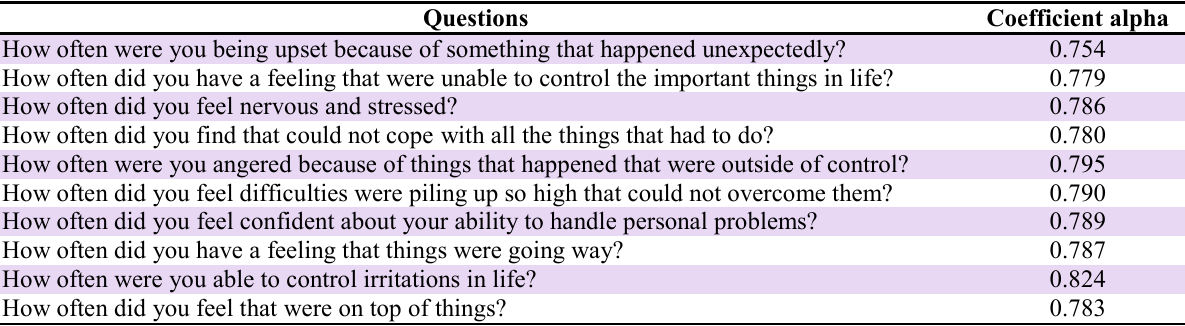
Figure 1. Types of scales for measuring of workplace stress, family functioning, and social identification of participants. Table 1. The questionnaire for measuring of workplace stress (by Cohen and